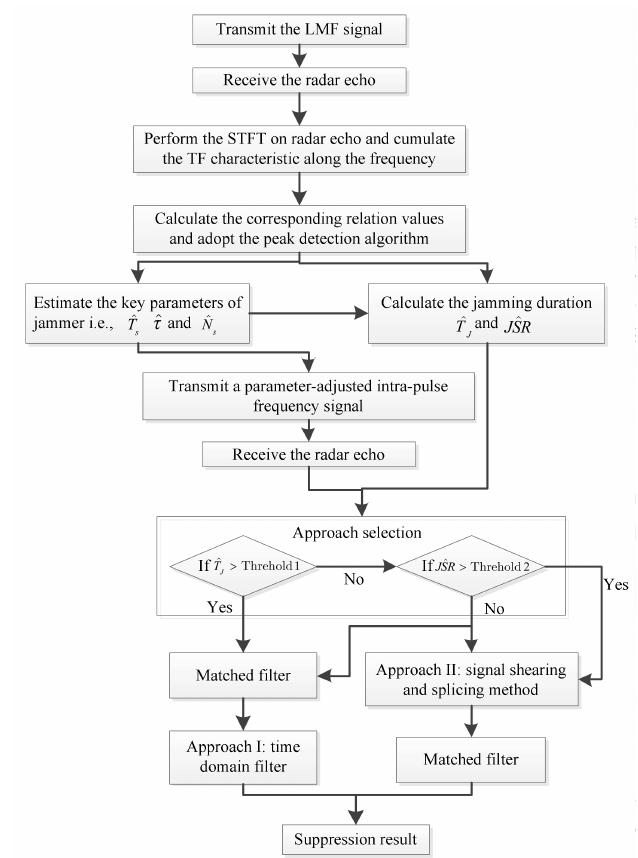
Figure 6. Flow chart of the proposed ECCM scheme.